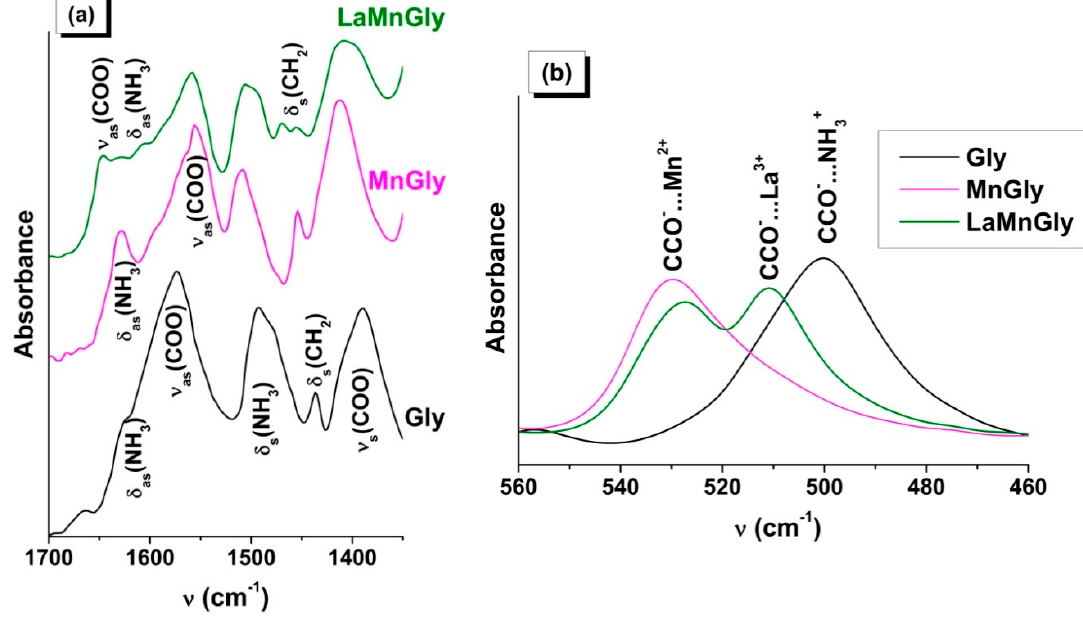
Figure 1. ( a ) ATR FTIR spectra of Gly, MnGly, and LaMnGly. ( b ) The region of deformational vibrations of the CCO groups.